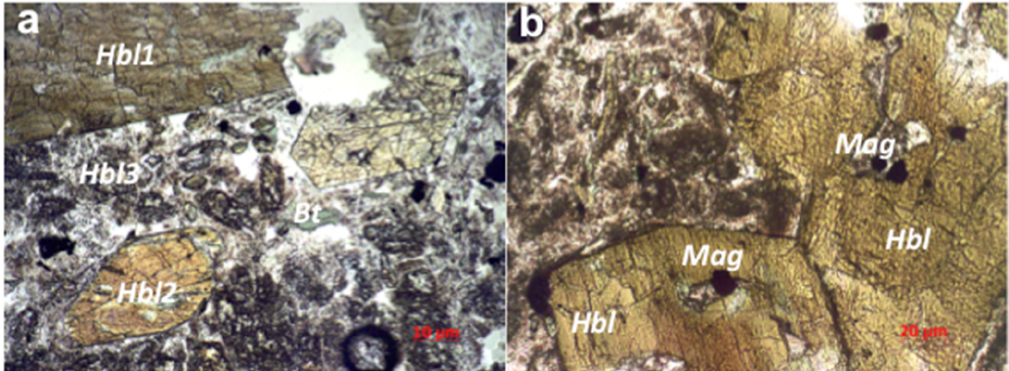
Figure 9. Petrographic features of Stanovoy adakites: ( a ) Porphyritic texture composed of three generations of hornblende (Hbl1—megacrysts, Hbl2—phenocrysts and Hbl3—groundmass) and biotite (Bt) phernocrysts; ( b ) zoned hornblende (Hbl) phenocrysts containing magnetite (Mag). Note that magnetite tends to occur in hornblende cores. Table 6. Representative mineral compositions (wt.%) in the Stanovoy Suture Zone